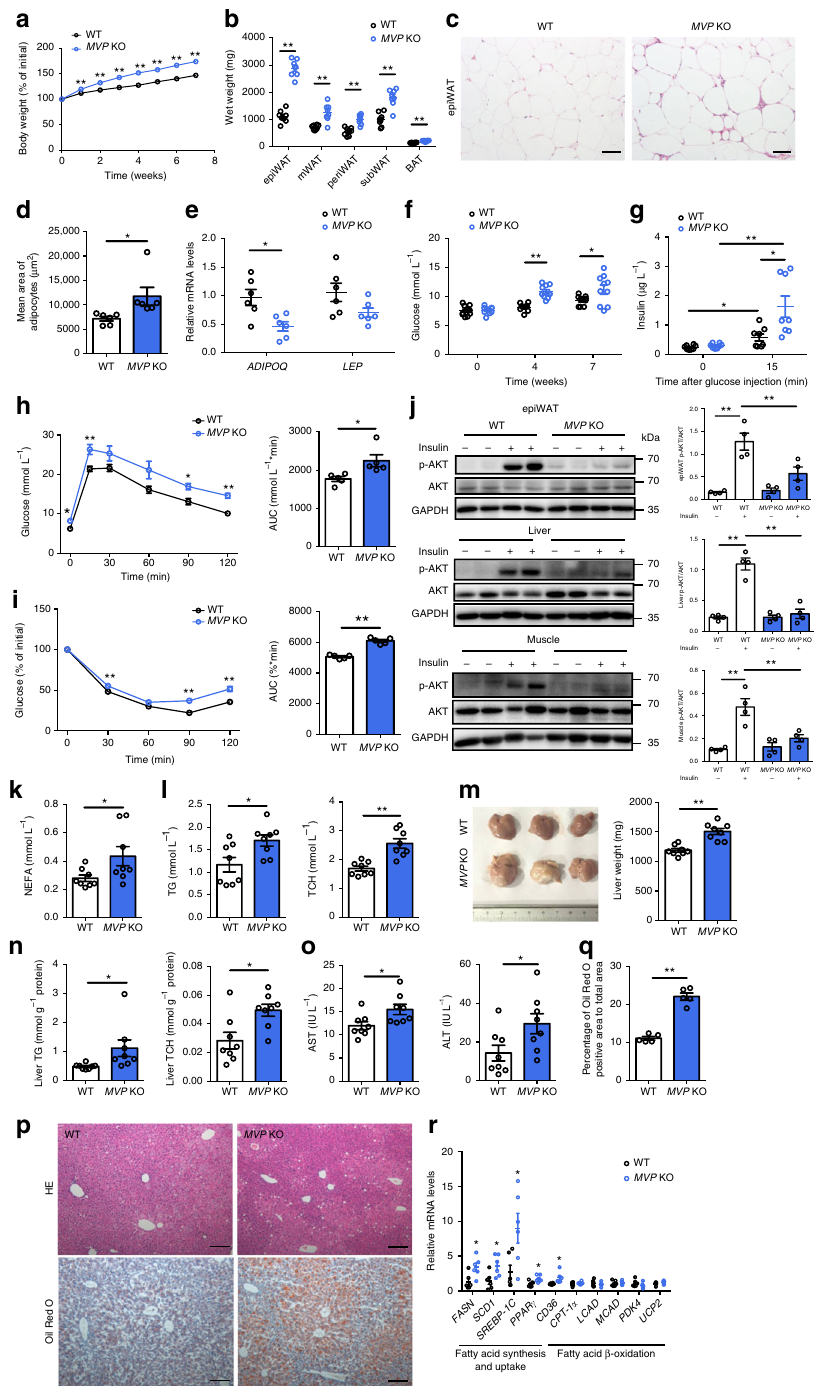
Fig. 2 MVP de fi ciency deteriorates HFD-induced metabolic disorders in mice. Male WT and MVP KO mice were fed a HFD for 7 weeks. a The percentage of body weight gain in WT and MVP KO mice ( n = 11). b Depot mass of epi, mesentery (m), perirenal (peri), subcutaneous (sub) WAT and BAT in WT and MVP KO mice ( n = 8). c H&E staining of epiWAT from WT and MVP KO mice. Scale bars, 50 μ m. d Quanti fi cation of adipocyte size in epiWAT of WT and MVP KO mice ( n = 6). e mRNA levels of ADIPOQ and LEP in epiWAT from WT and MVP KO mice ( n = 6). f Fasting blood glucose in WT and MVP KO mice ( n = 10). g Basal- and stimulated-insulin levels in WT and MVP KO mice ( n = 8). h , i GTT and ITT in WT and MVP KO mice ( n = 5). j Western blot of AKT phosphorylation in the murine epiWAT, liver, and skeletal muscle stimulated by insulin. k , l Plasma levels of NEFA ( k ), TG and TCH ( l ) in WT and MVP KO mice ( n = 8). m , n Murine liver tissues were retrieved after 7 weeks of HFD feeding and their wet weights ( m ), liver TG and TCH ( n ) levels were determined ( n = 8). o Plasma levels of AST and ALT in mice ( n = 8). p H&E (top) and Oil Red O (bottom) staining of representative liver sections obtained from HFD-fed WT (left) and MVP KO (right) mice. Scale bars, 100 μ m. q Quanti fi cation of Oil Red O stained area of liver ( n = 5). r mRNA levels of lipid metabolism-related genes in livers from WT and MVP KO mice ( n = 6). Data are expressed as mean±SEM. * P <0.05 and ** P <0.01 by Student ’ s t test or ANOVA with post hoc